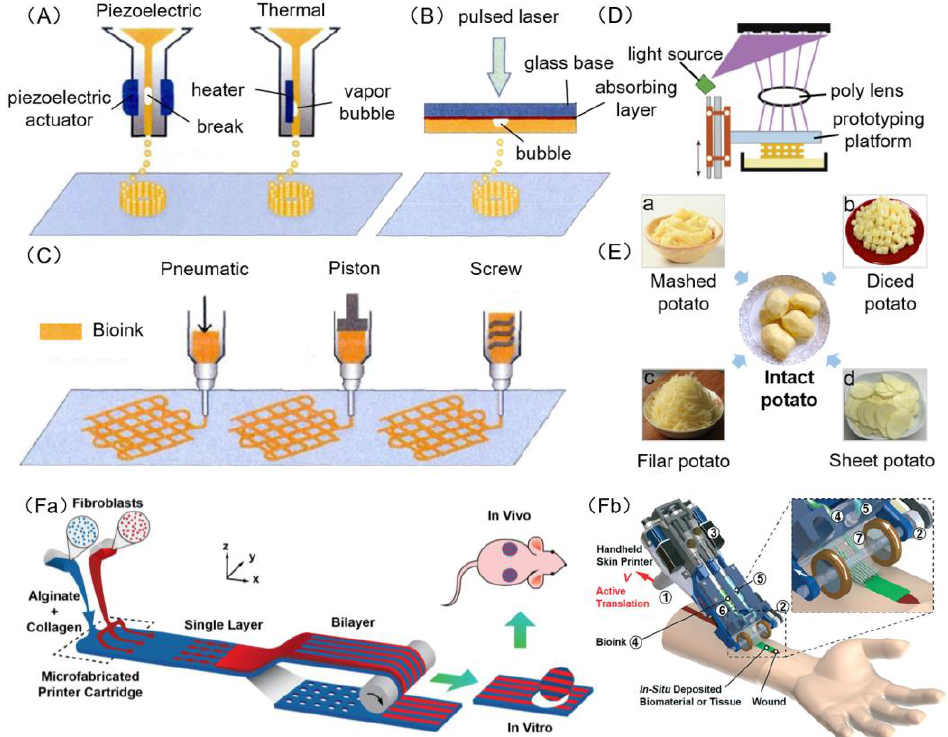
Figure 3. Schematic diagram of 3D bioprinting. ( A ) Piezoelectric inkjet bioprinters form pulses by piezoelectric pressure to force droplets from the nozzle, while thermal bioprinters use air-pressure pulses produced by a printhead that is electrically heated. ( B ) Laser bioprinters use laser focused on